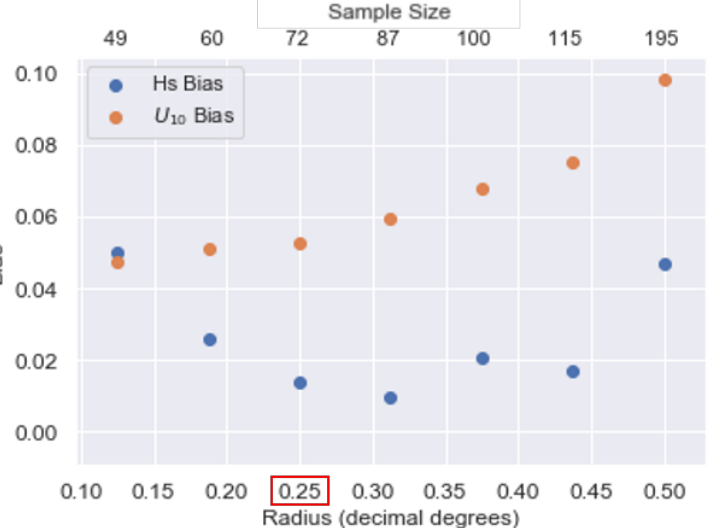
Figure 2. Pass averaged SARAL/AltiKa sample size and proportional bias around Buoy 44025. The red box highlights R p 25